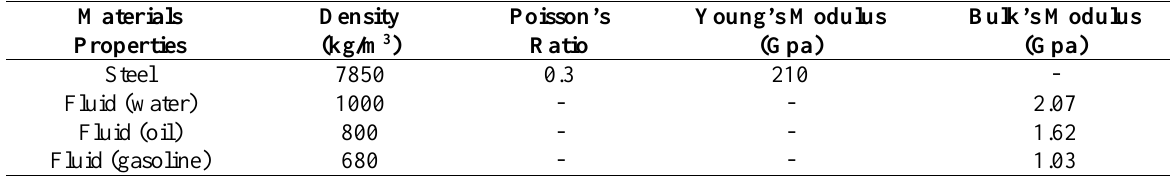
Table 3. Material properties used in the analysis